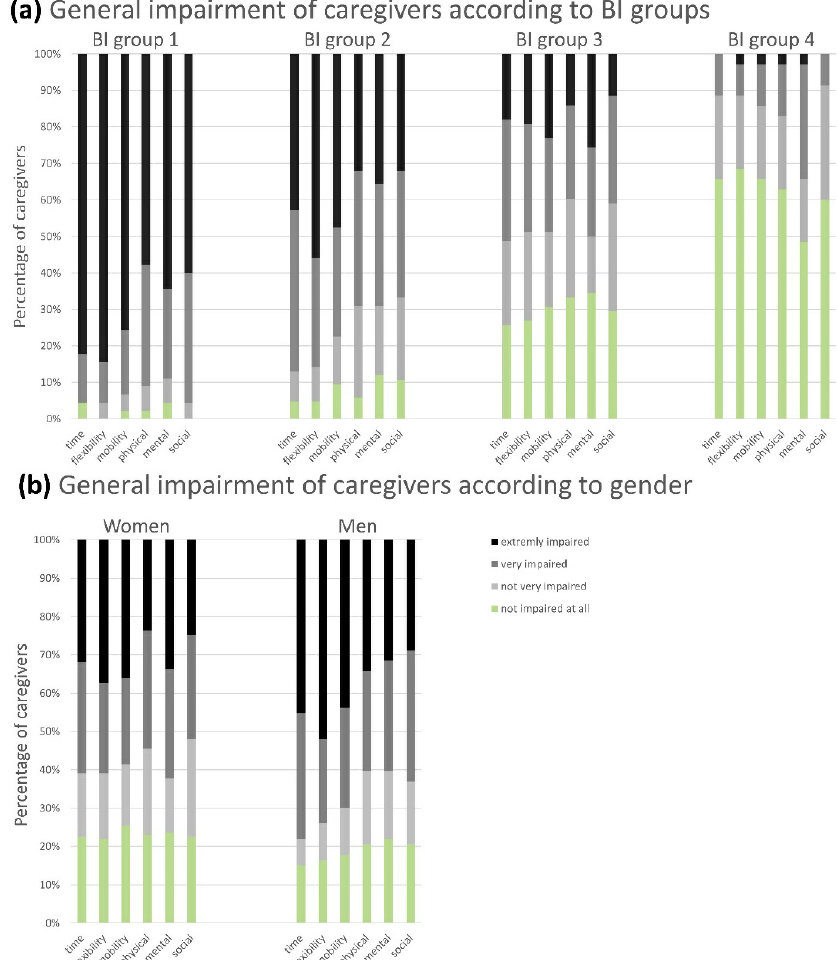
Figure 2. General impairment of caregivers according to BI groups ( a ) and gender ( b ): The caregivers were able to indicate their perceived general impairment in different dimensions of their everyday life on a four-point Likert scale from “not impaired at all” to “extremely impaired”. Six adjacent columns are assigned to one distinct BI group ( a ) or gender ( b ). One column corresponds to one domain. The extent of the colored sections represents the percentage of answers provided by the CGs on the abovementioned scale. The proportion of “very/extremely” impaired CGs increased with the loss of autonomy of the patient (BI group 4 (= BI score 100 points = full independence) to BI group 1 (= BI score 0–20 points = full dependence)), and the number of “not very/not at all” restricted CGs correspondingly decreased ( a ), while no significant differences were observed according to the CGs’ gender ( b ). Abbreviations: BI = Barthel Index; CGs = caregivers.